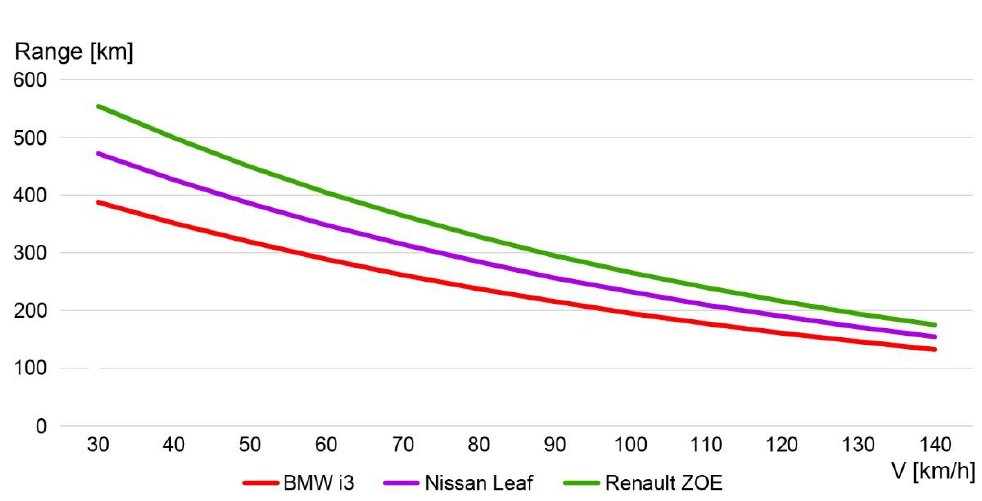
Figure 1. The range of the three most popular electric vehicles in Poland in relation to average speed of travel based on the exponential function.